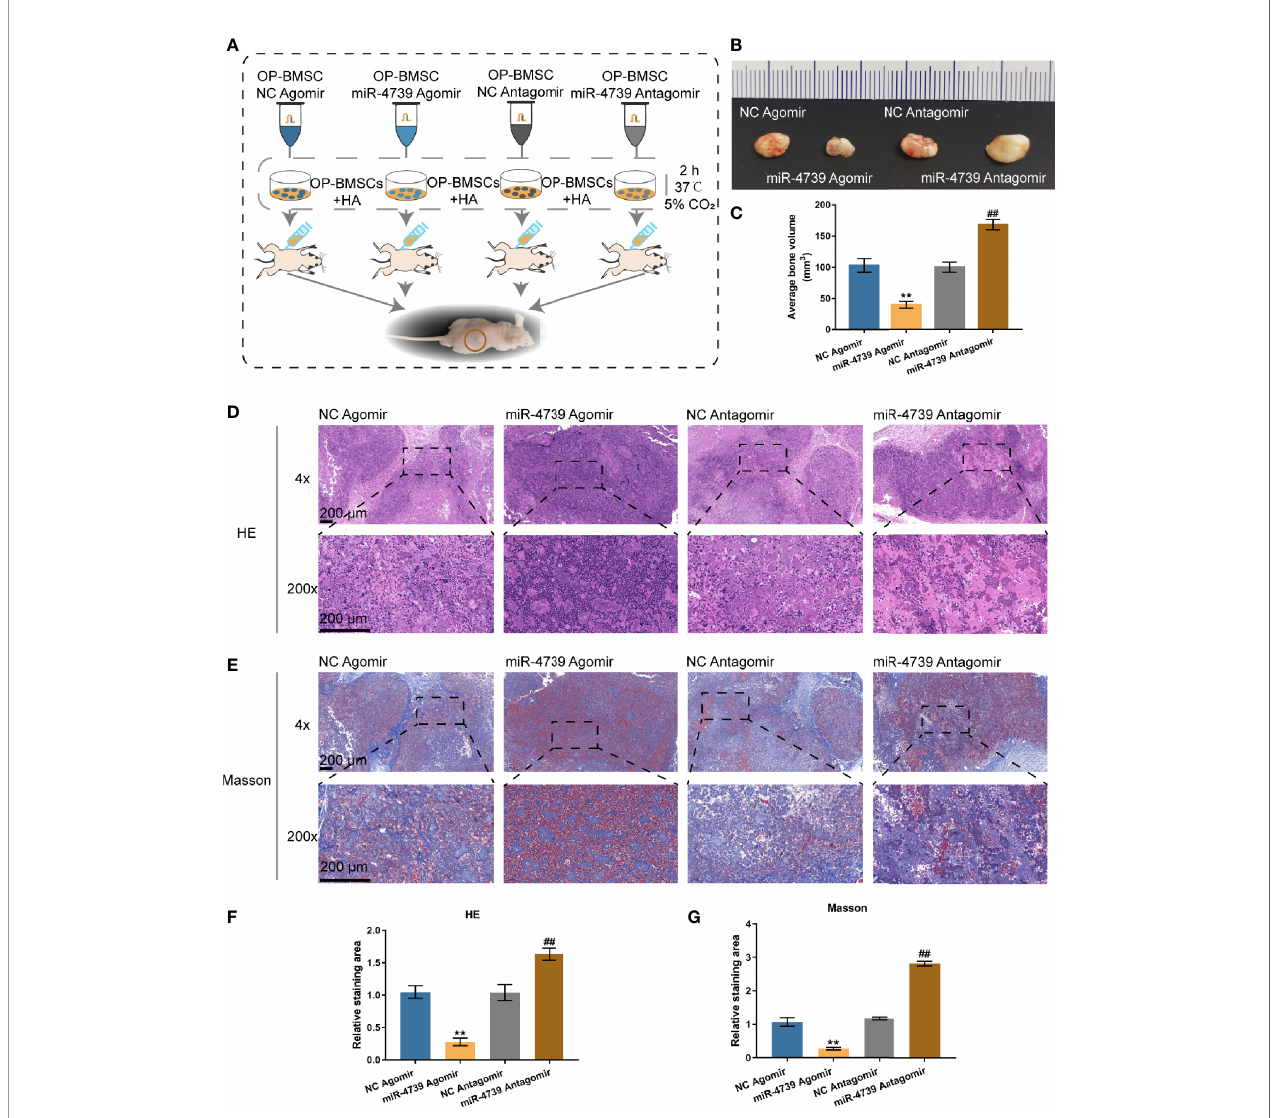
FIGURE 4 | miR-4739 modulated heterotopic bone formation from osteoporotic BMSCs in vivo . (A) The protocol of heterotopic bone formation. (B, C) Gross view and volume of heterotopic bone from miR-4739 agomir or antagomir transfected osteoporotic BMSCs. (D, E) Histological analysis of heterotopic bone formation with HE and Masson staining (the scale bar is 200 m m). The relative staining area of HE and Masson was shown in (F, G) . n=4. ** P < 0.01, compared to NC agomir; ## P < 0.01, compared to NC